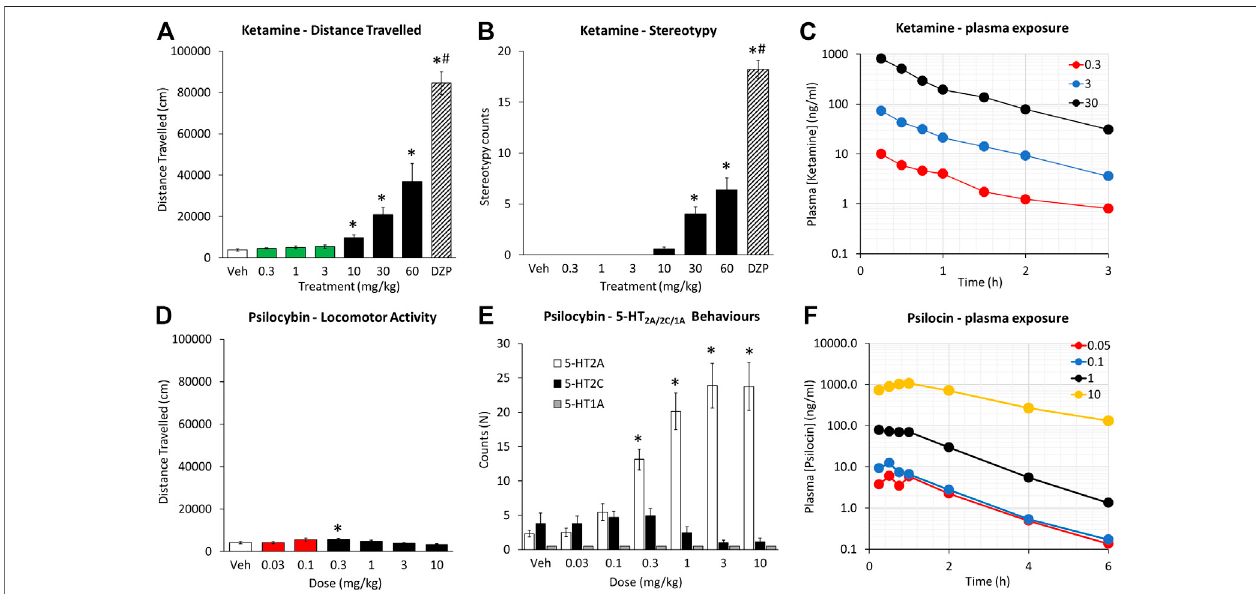
FIGURE 1 | Characterisation of ketamine (0.3 – 60 mg/kg IP) and psilocybin (0.03 – 10 mg/kg SC) on locomotor activity, measured as distance traveled over a 2 h test period (A and D) , behavioral stereotypies recorded over the same test period (B and E) , and plasma [ketamine] and [psilocin] levels as a function of time post injection ofketamine (0.3 – 30 mg/kgIP) and psilocybin (0.05 – 10 mg/kgSC) (Cand F) . Datafordistancetraveled ispresentedon thesame axisscalestoemphasize the differences in magnitude of effect between the two drugs. The green and red highlighted bars are to emphasize the dose ranges of ketamine and psilocybin that were de fi ned as low doses, and used for the progressive ratio and 5-choice experiments. Behavioral signs characterized as 5-HT2AR were a composite of WDS/BMC, 5-HT2CR a composite of YPG, 5-HT1AR a composite of HLA/FPT (see Halberzettl et al., 2013). Dizocilpine (DZP; 0.1 mg/kg SC) was included as a reference comparator in the ketamine experiment. * p < 0.05 vs. vehicle control, # p < 0.05 vs. all treatment groups (see Data analysis